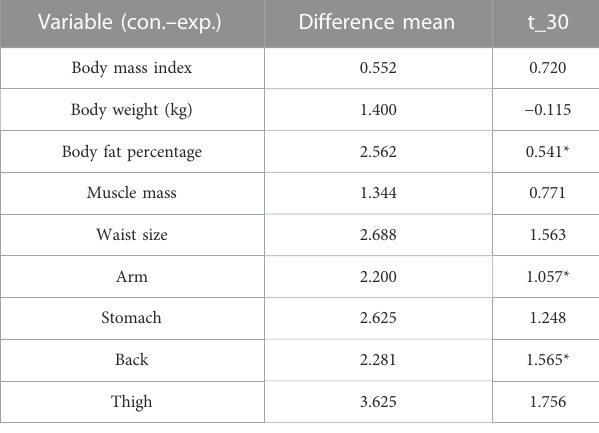
TABLE 4 Results of the T-test for independent samples: The differences of the control group and experimental group scores in the fi nal state. Variable (con. –